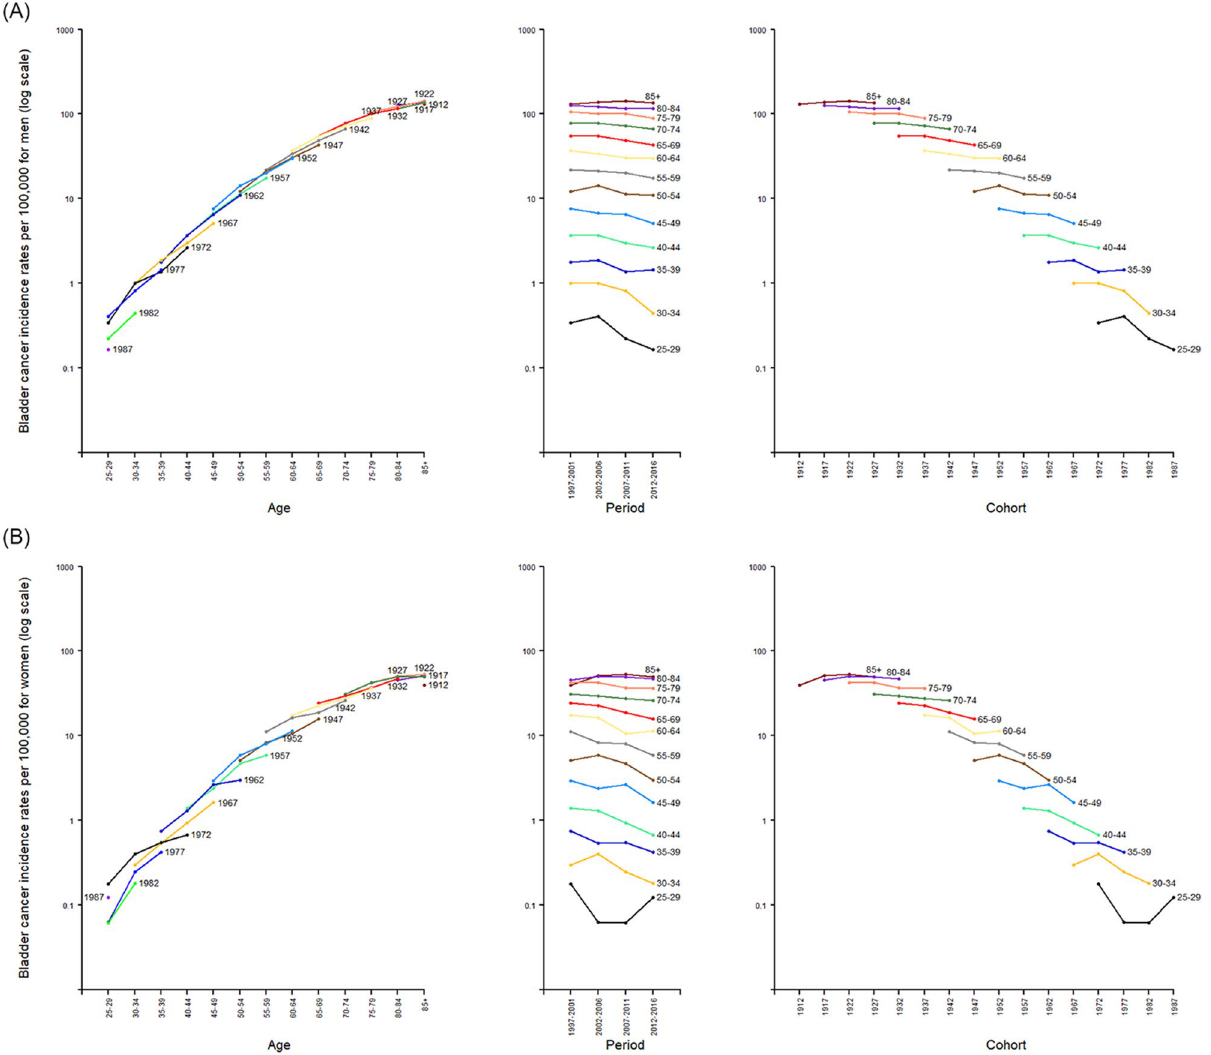
Figure 2. Bladder cancer incidence rates in Taiwan for men ( A ) and women ( B ) by age, period, and